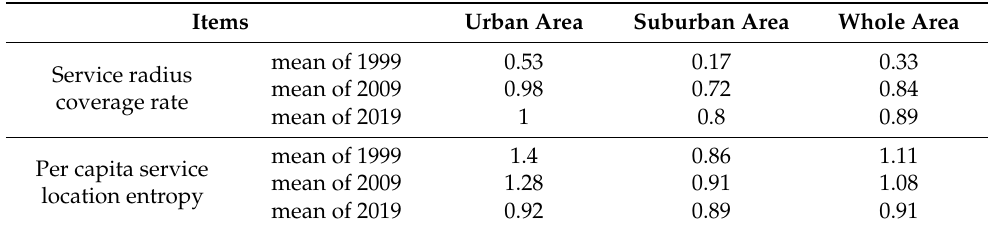
Table 1. Differences in social performance of community sports and fitness venues between urban areas and suburban areas. Items Urban Area Suburban Area Whole Area mean of 1999 0.53 Service radius coverage rate